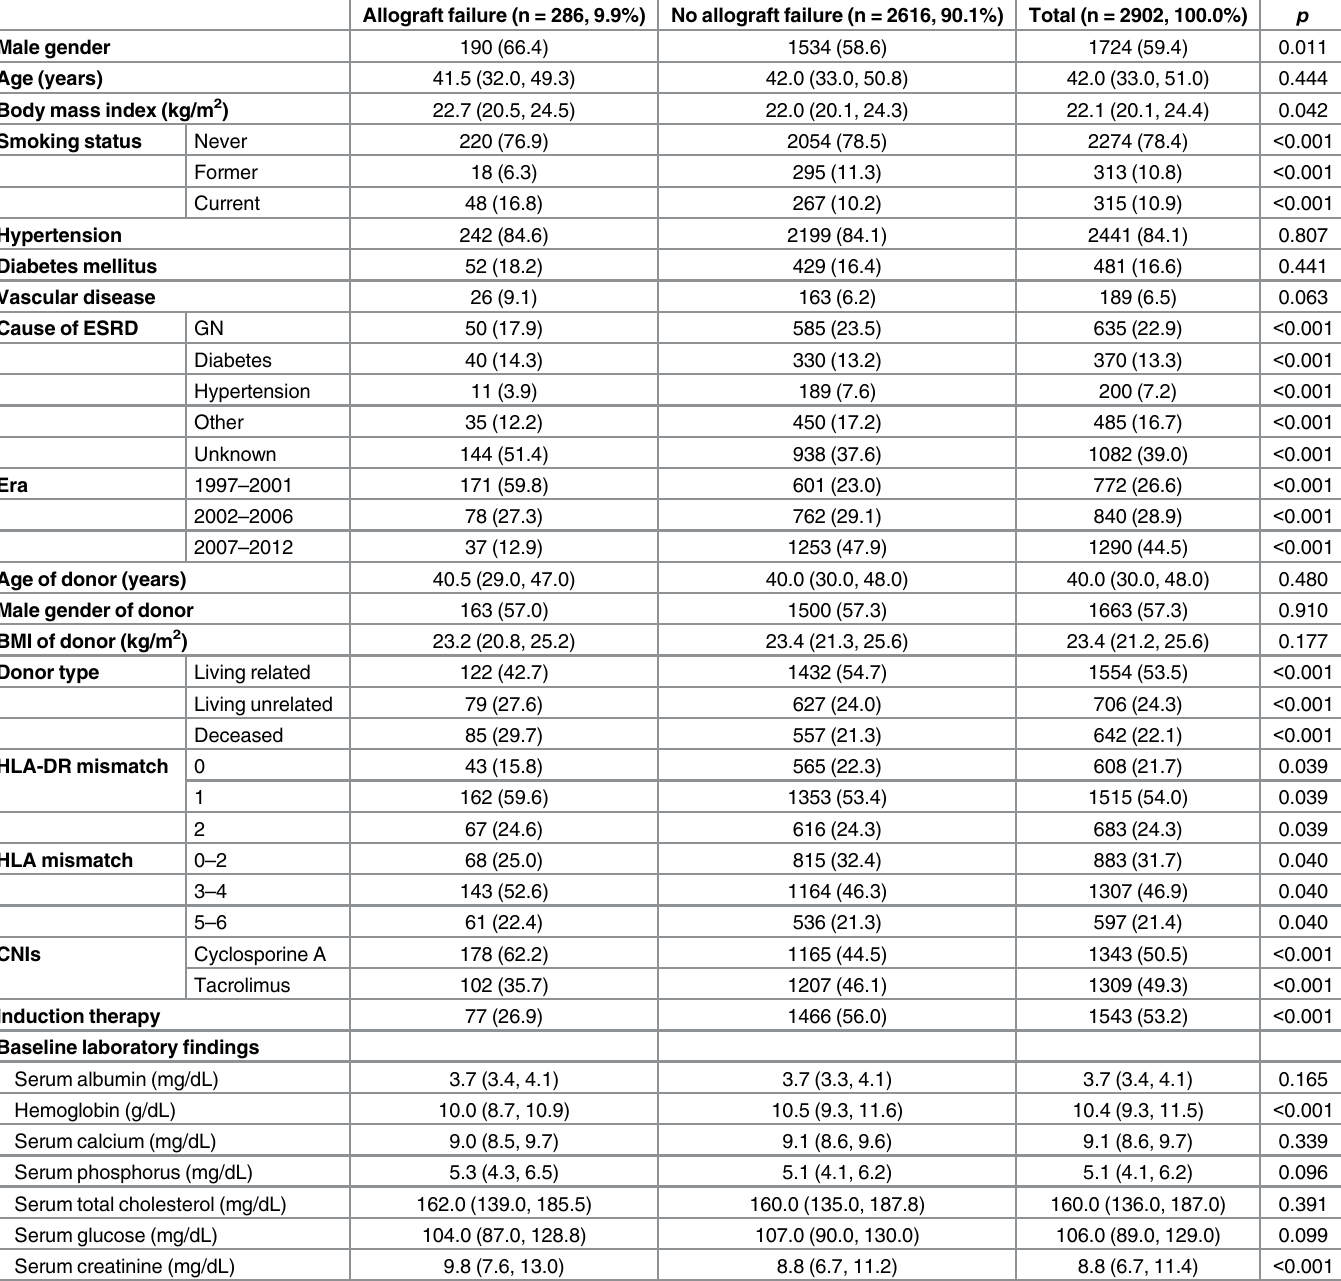
Table 2. Demographics and baseline clinical characteristics according to the development of allograft failure. Allograft failure (n = 286, 9.9%) No allograft failure (n = 2616,